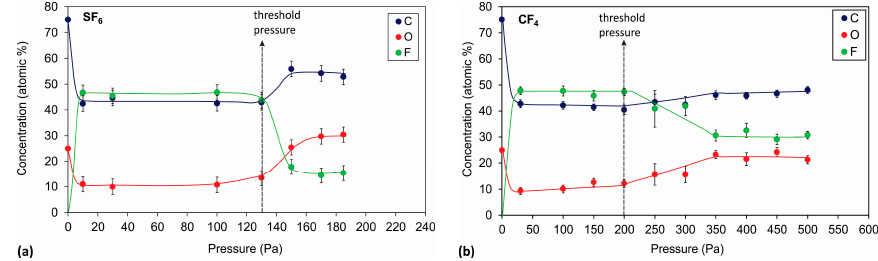
Figure 2. Surface composition of the PET samples treated at various pressures, as determined by XPS: ( a ) treated in SF 6 plasma and ( b ) treated in CF 4 plasma. Two different regions regarding the surface composition are observed at low/high pressures. The values of the atom concentration at a pressure of 0 Pa correspond to the untreated sample.